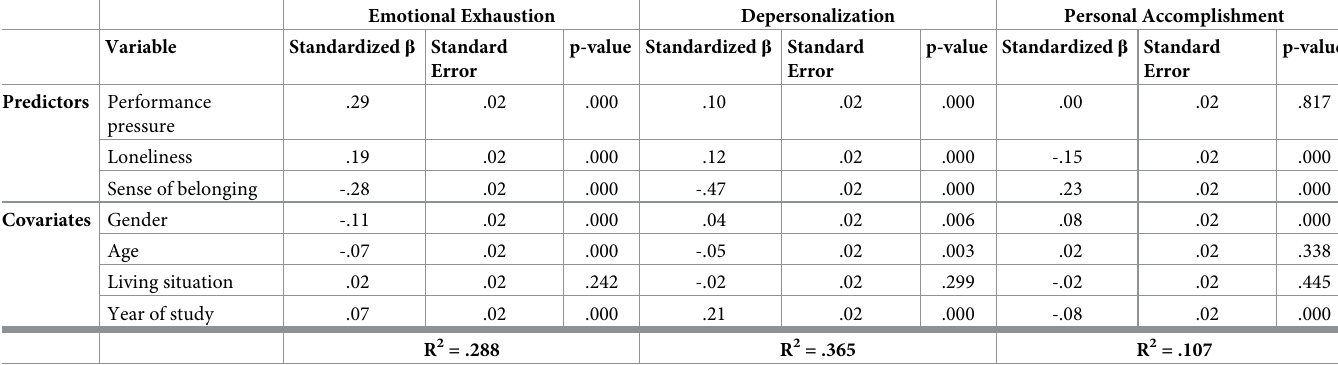
Table 3. Emotional exhaustion, depersonalization and personal accomplishment explained by multiple regression analysis (N =